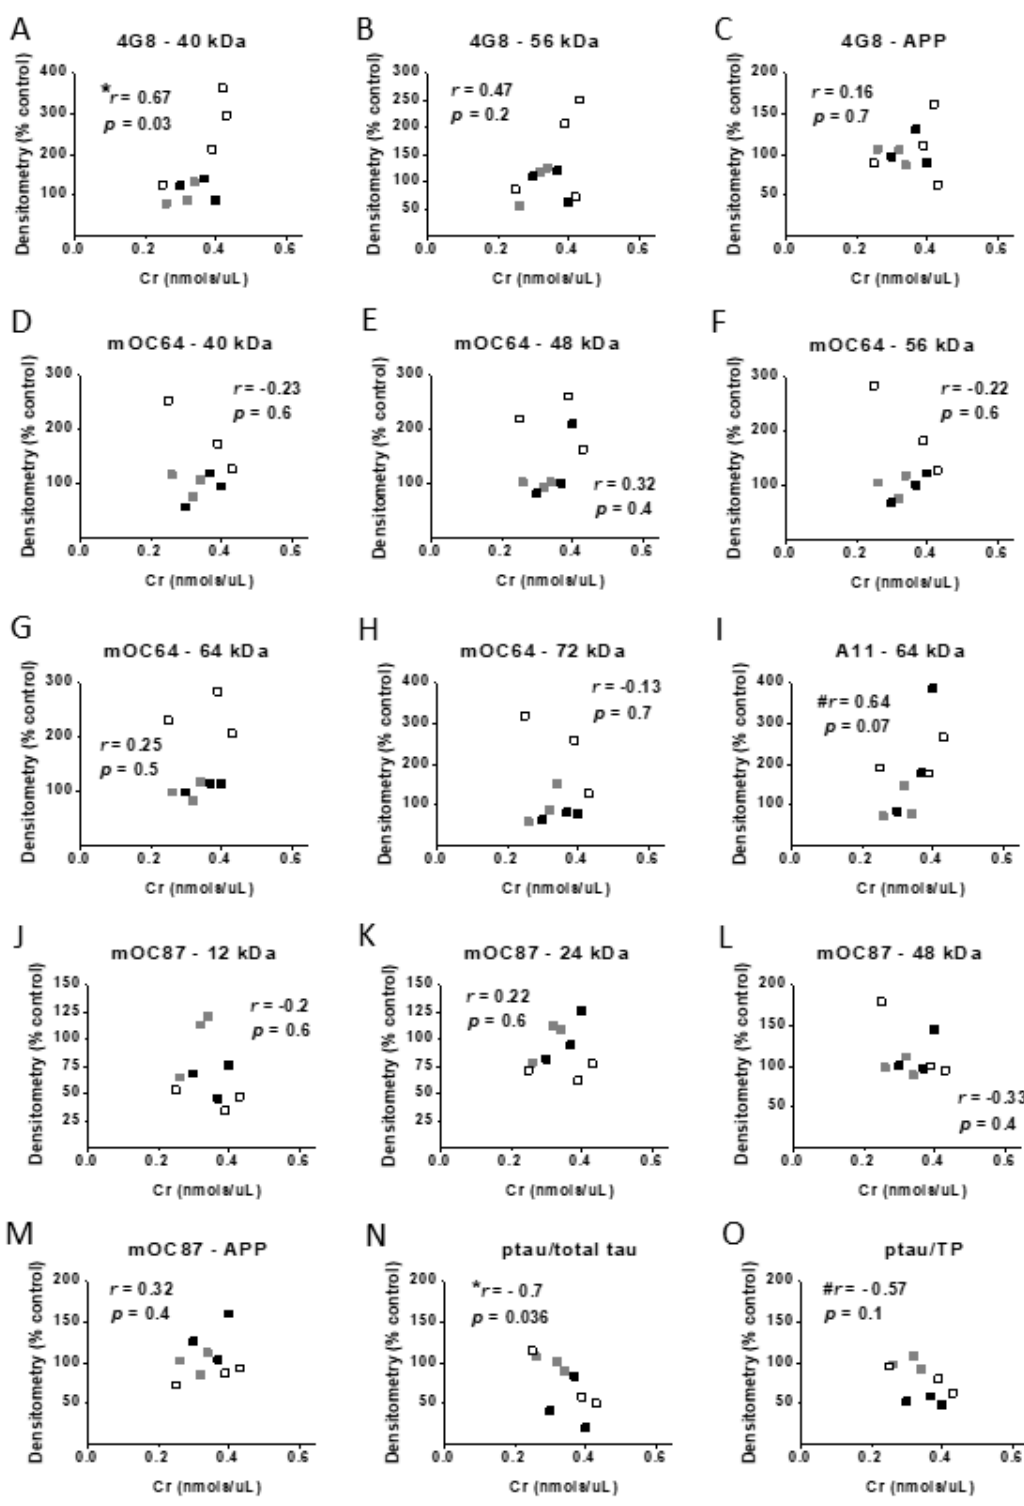
Figure 13. Correlational analyses between Cr and Alzheimer’s disease- (AD) related protein levels. Pearson correlation coefficients between hippocampal Cr levels and relative normalized densitometry values from Western blot experiments measuring amyloid β (A β ) species and/or APP with antibodies ( A – C ) 4G8, ( D – H ) moc64, ( I ) A11, and ( J – M ) moc87 or ( N , O ) AT8 to measure hyperphosphorylated tau in control-fed male (black squares) and female (gray squares) 3xTg mice, as well as female 3xTg mice on a Cr-supplemented (white squares) diet. Note: n = 3–4, * p < 0.05, # p < 0.01.